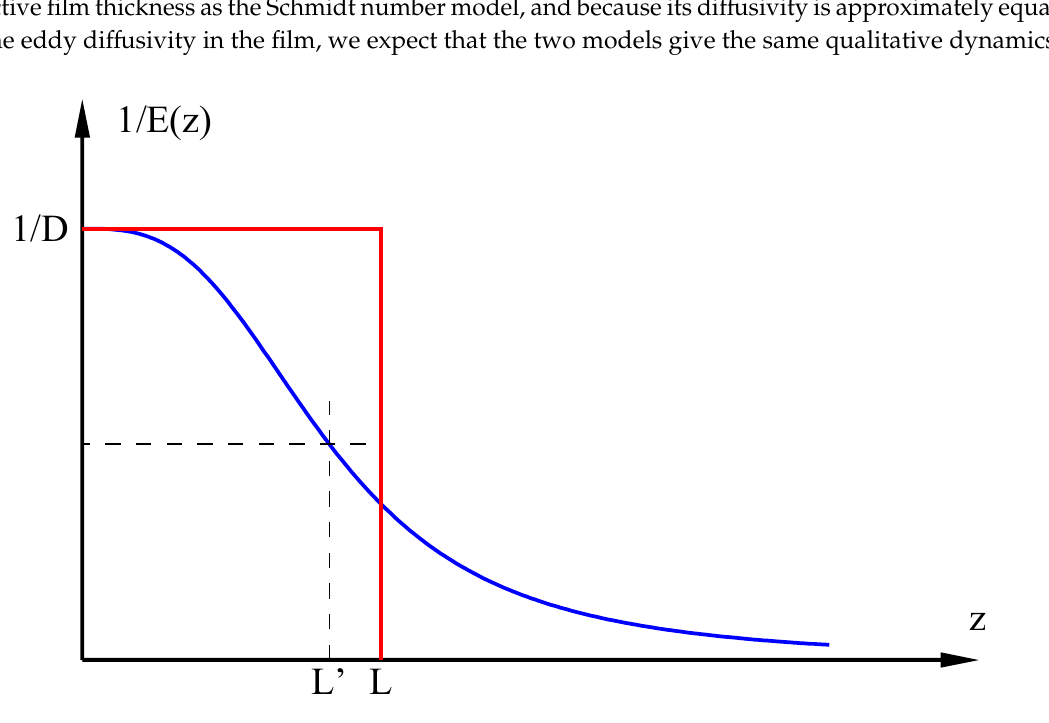
Figure 3. The red rectangle and blue curve are 1 / E ( z ) for E ( z ) as given in Equations (3) and (4), respectively. They are drawn with the same area under the curves. L ’ is the width at half-height of the blue curve; the area under the blue curve scales as L ’/ D . The red rectangle has area L / D .